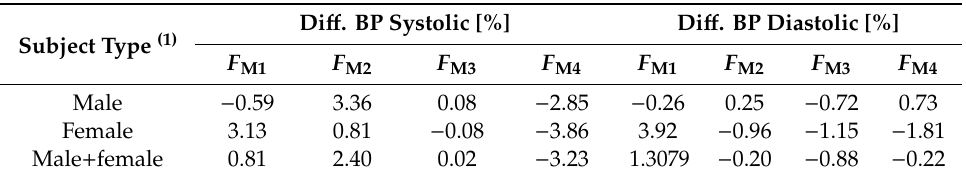
Table 4. Mean differential values of BP parameters determined in relaxation ( F M1,4 ) and stimulation ( F M2,3 ) phases for persons examined in the MRI device.